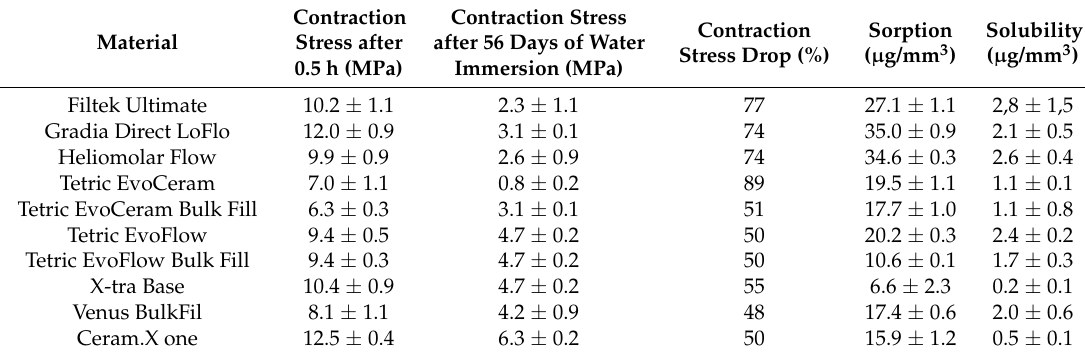
Table 1. Contraction stress before and after 56 days water immersion, contraction stress drop, absorbency, and solubility of tested